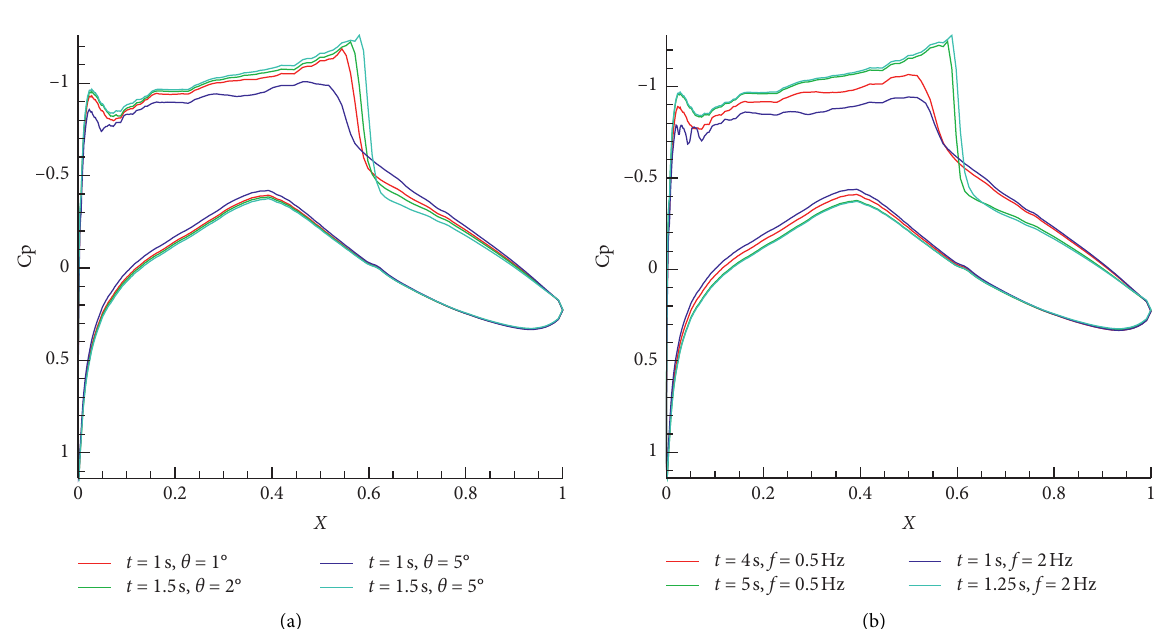
Figure 18: Influence of camber deformation on pressure distribution